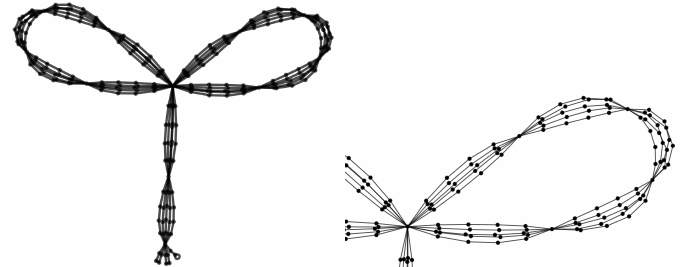
Figure 19. A 5 4 illustrates the concept of spray. The left panel shows the entire graph while the right panel is a blow-up of one of the petals. Five first-order sprays are connected to the ultimate vertex and each penultimate vertex is terminated by two sprays. Because q = 5, the first-order sprays have five paths each and each path consists of five edges and four intermediate degree 3 vertices. Application of the renormalization scheme discussed in the text would yield A 5 2 , which is shown in Figure 17.